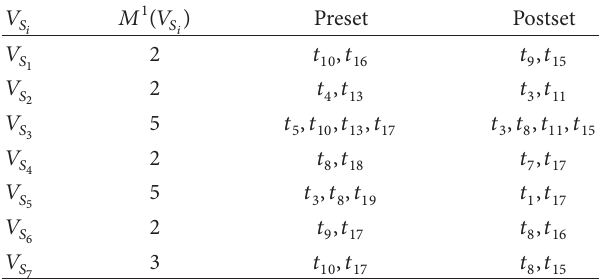
Table 2: Monitors added at the first